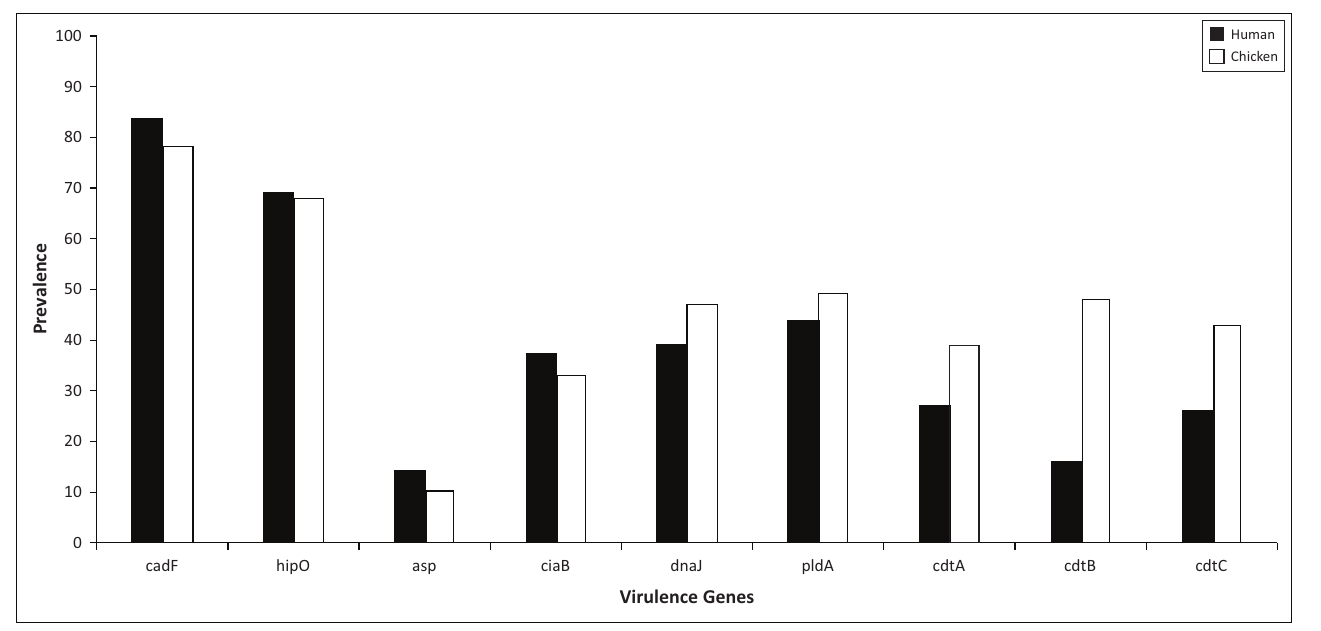
FIGURE 2: Prevalence of virulence genes in Campylobacter spp. in human clinical isolates and chicken